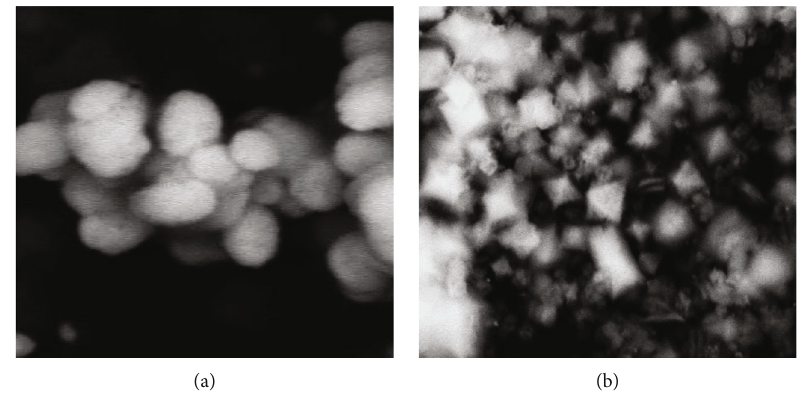
Figure 3: SEM micrographs SEM (1000x) of (a) MIL-100-Fe and (b) MIL-101-Fe.